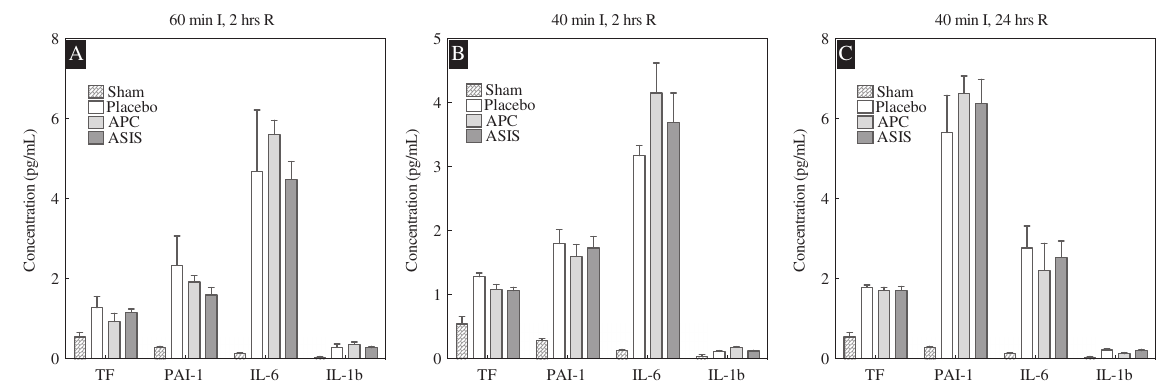
Figure 5. Effect of APC and ASIS on RNA expression level after Panel A: 1 hr of ischemia and 2 hr of reperfusion, Panel B: 40 min of ischemia and 2 hr of reperfusion, and Panel C: 40 min of ischemia and 24 hr of reperfusion. Values are mean ± SEM, n = 6, * sham vs. placebo, # ASIS vs. placebo, $ APC vs. placebo, p < 0.05.